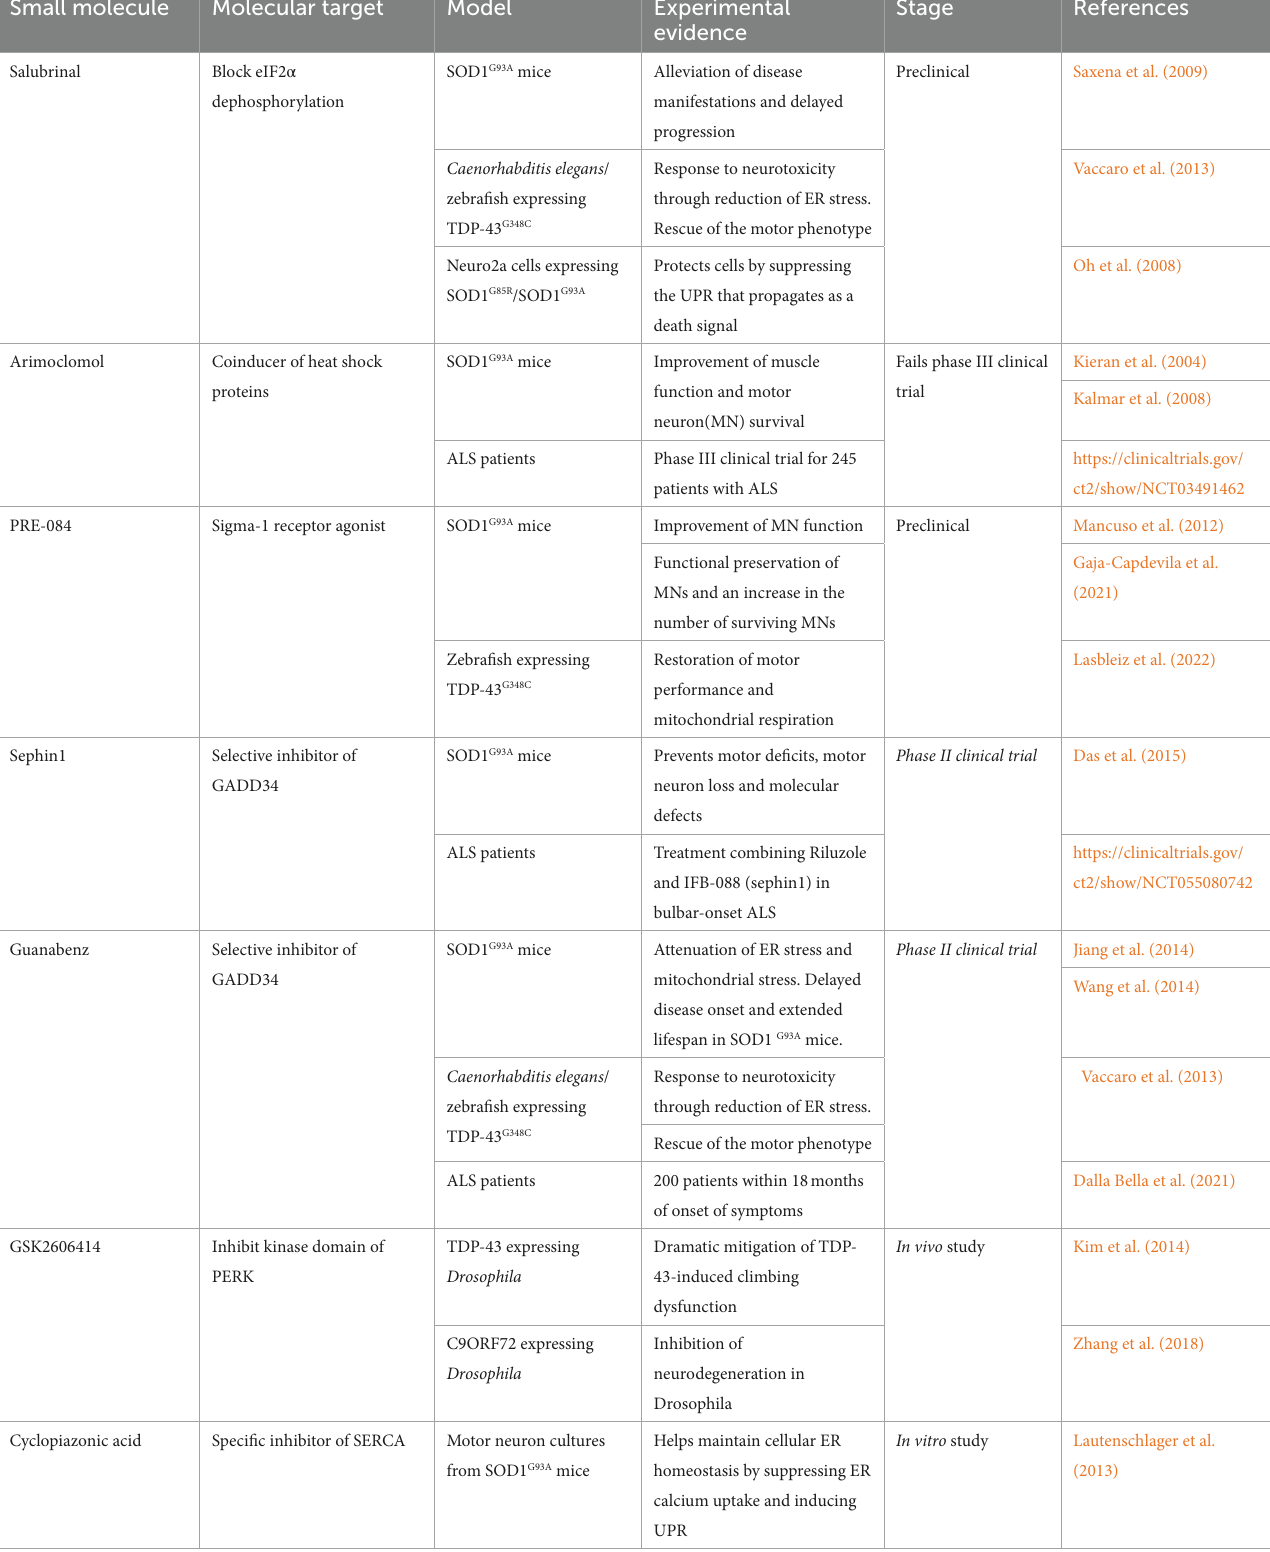
TABLE 1 Small molecules targeting the unfolded protein response (UPR) pathway for amyotrophic lateral sclerosis (ALS) treatment. Small